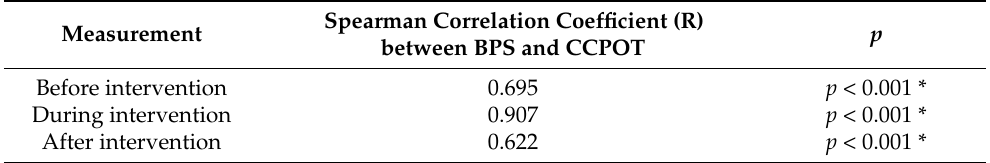
Table 5. Correlations between BPS and CCPOT scores. Spearman Correlation Coefficient (R) p Measurement between BPS and CCPOT Before intervention 0.695 p < 0.001 * During intervention 0.907 p < 0.001 * After intervention 0.622 p < 0.001 *